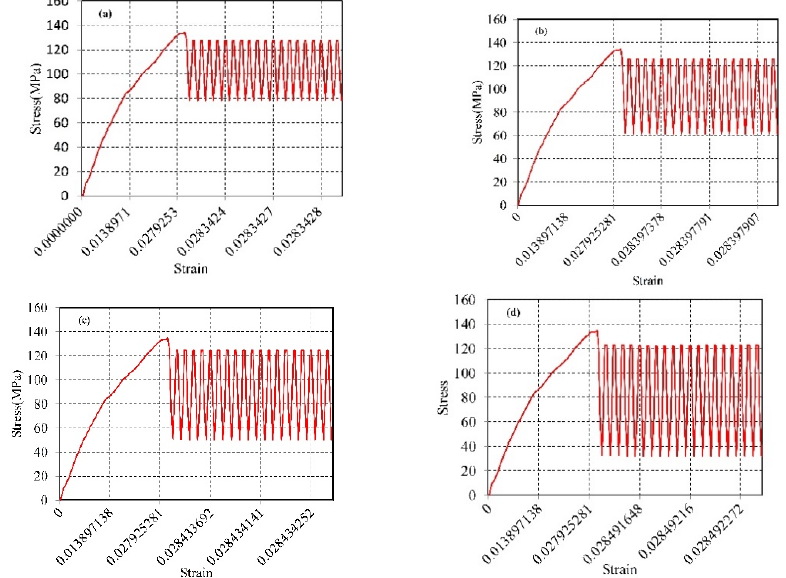
Figure 12. The simulation stress-strain curves under different amplitudes of the ultrasonic frequency 28 kHz, ( a ) Amplitude 3 μ m; ( b ) Amplitude 4.8 μ m; ( c ) Amplitude 6.3 μ m; and ( d ) Amplitude 7.8 μ m.